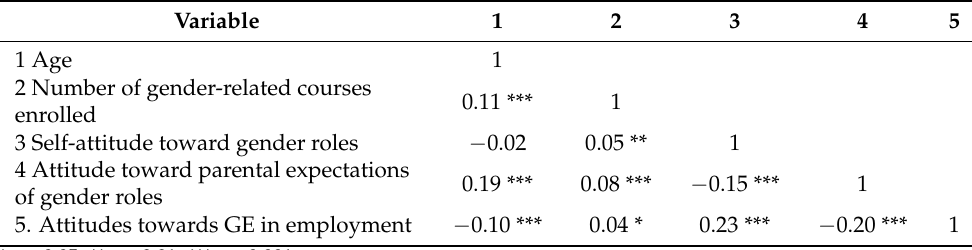
Table 4. Pearson product-moment correlation analysis of the attitudes towards GE in employment ( n =